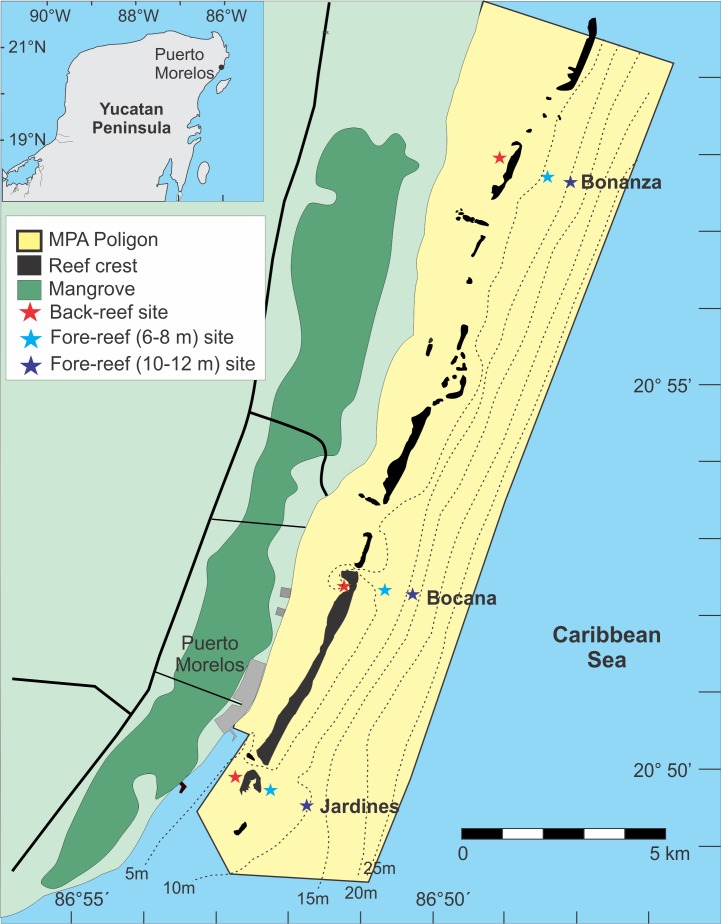
Location of the study sites (figure modified from Monroy-Velázquez & Alvarez (2016)).The color of the star indicates the reef depth where the samples were collected.